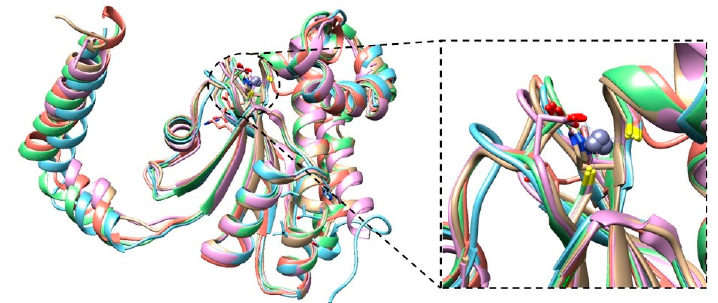
Figure 2. Superposition of the Bps β CA structure (brown), with the previously determined type II β -CAs from Pseudomonas aeruginosa (cyan, r.m.s.d of 0.784 Å), Porphyridium purpureum (violet r.m.s.d of 0.749 Å), Salmonella typhimurium (green r.m.s.d of 0.785 Å), and Vibrio cholerae (red r.m.s.d of 0.952 Å).